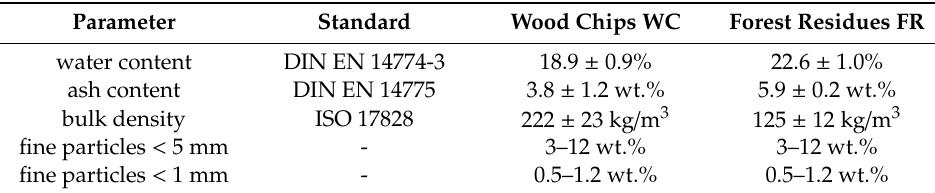
Table 1. Selected fuel properties of the utilized